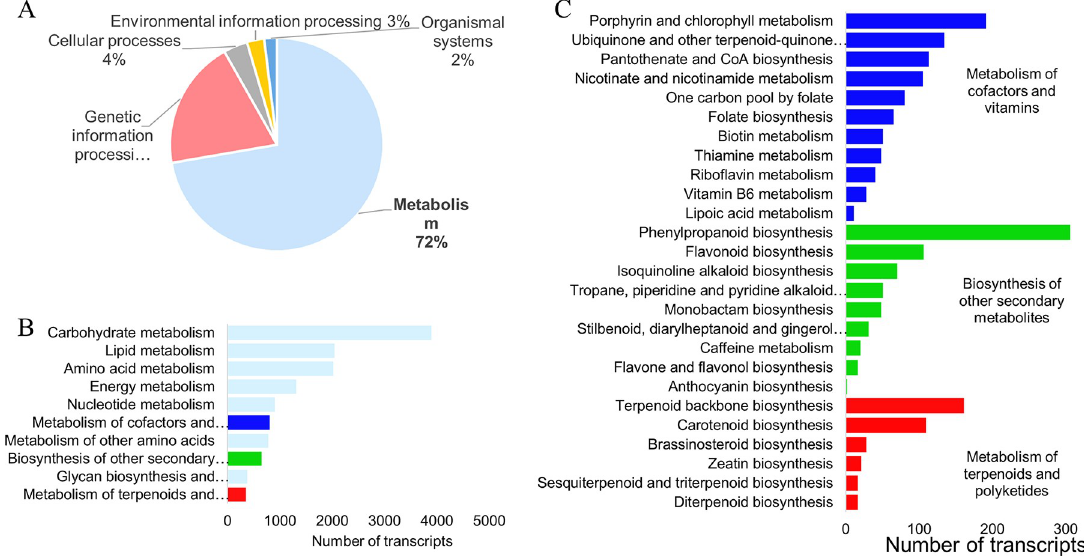
Fig 2. KEGG pathway annotation. A) General representation of the annotated transcripts. B) Pathway groups integrated into ‘metabolism’ C) Pathways grouped under three categories of metabolism’: ’Metabolism of cofactors and vitamins’, ‘Biosynthesis of other secondary metabolites’ and, ‘Metabolism of terpenoids an